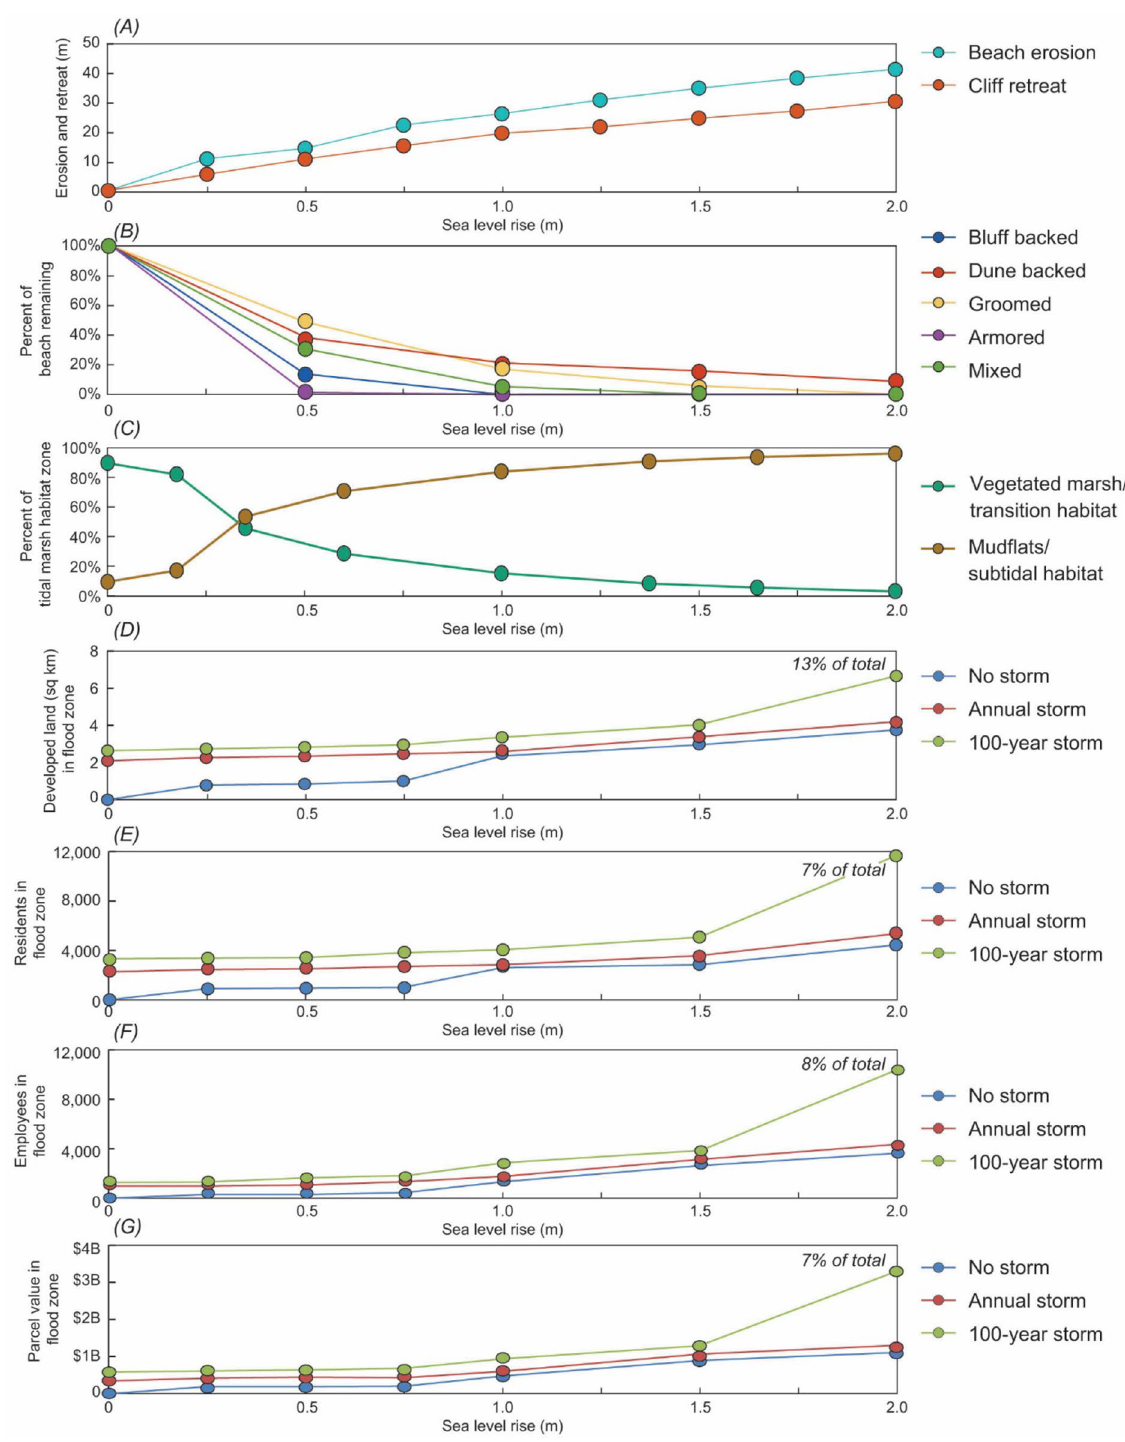
Figure 3. Projected changes in coastal systems for the Santa Barbara study area. ( A ) Beach erosion and cliff retreat projections, ( B ) the percent of beach remaining along transects, ( C ) the percentage of vegetated marsh/ transition habitat (upland, transition zone, and high/mid marsh) and high/low mudflat and subtidal habitat in Carpinteria salt marsh, and the amount of various community assets in projected flood zones including ( D ) developed land, ( E ) residents, ( F ) employees, and ( G ) parcel values relative to sea level rise scenarios from 0 to 2